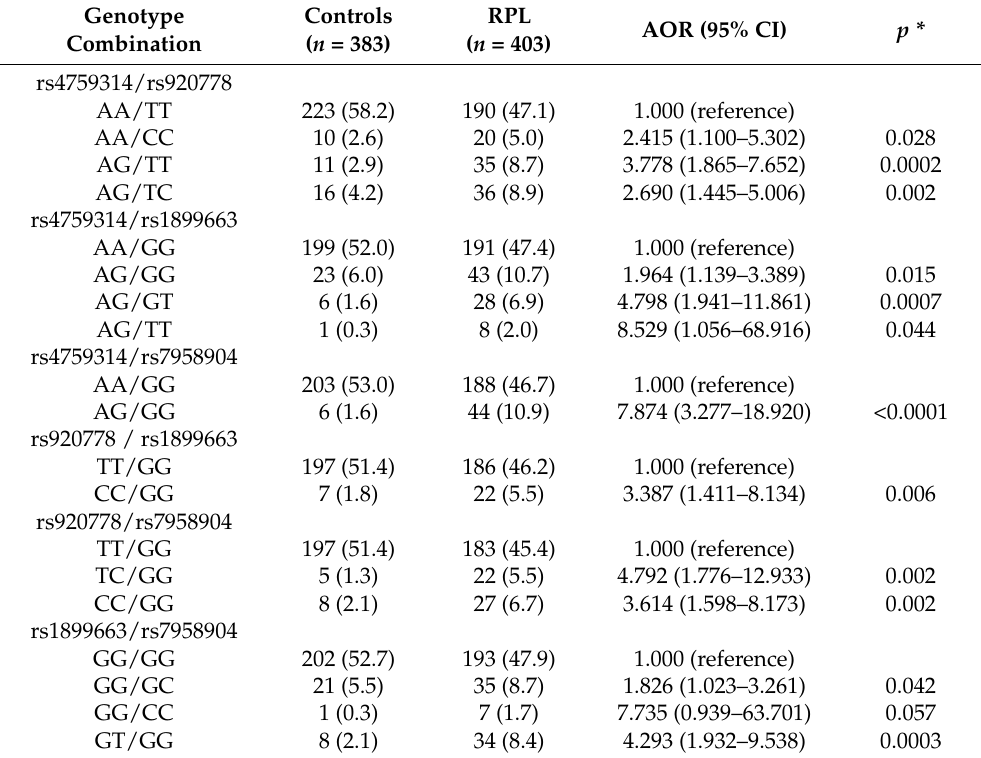
Table 4. Combined genotype analysis for the HOTAIR polymorphisms rs4759314A>G,